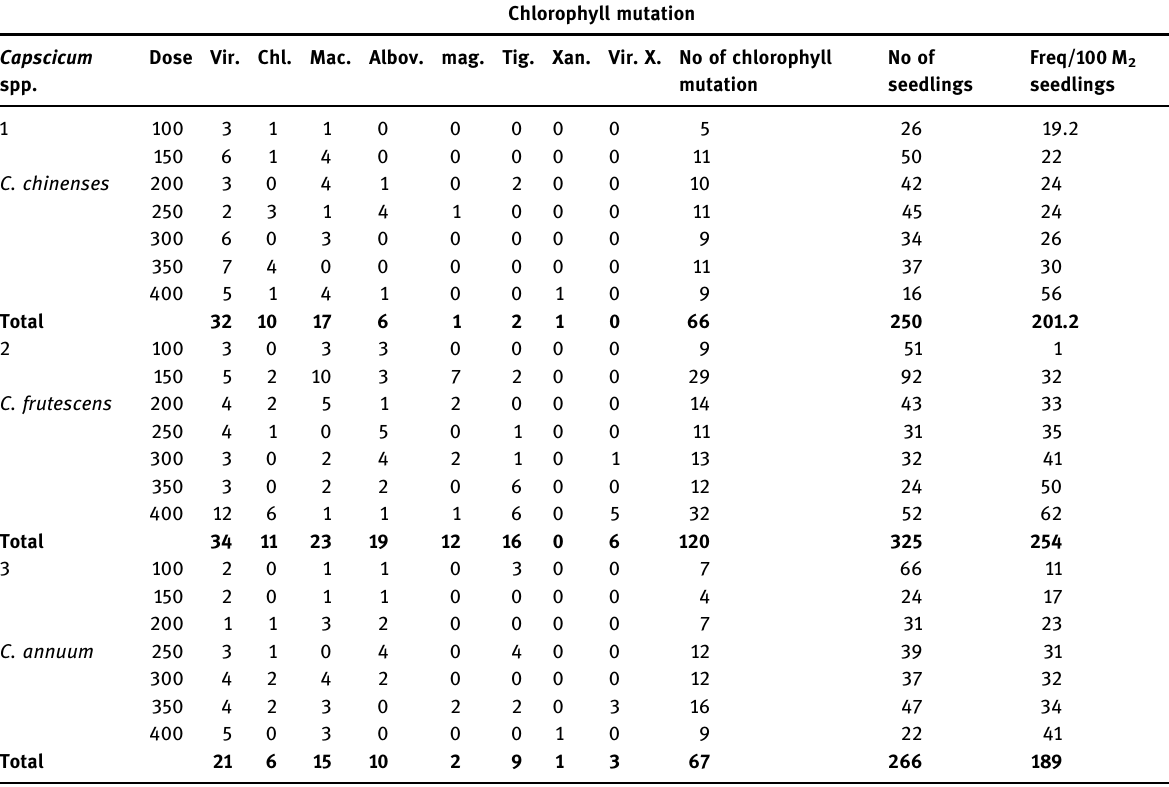
Chlorophyll mutation